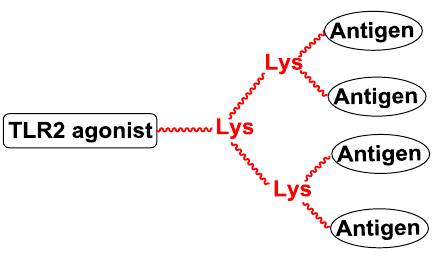
Figure 7. Multivalent template of polylysine.